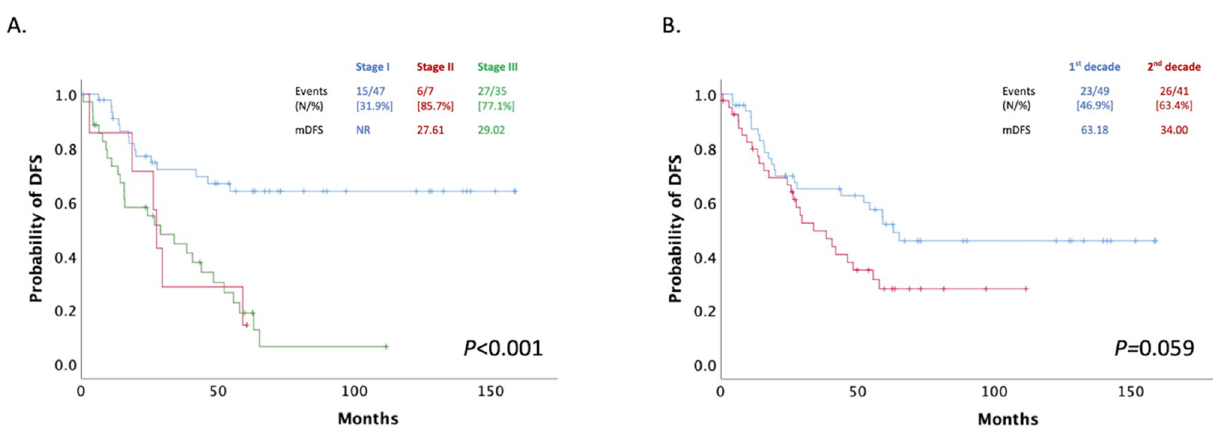
Figure 2. ( A ) Patients mDFS stratified by stage; ( B ) Patients mDFS after adjuvant treatment stratified by decade of treatment (1st decade: 1999–2009, 2nd decade: 2009–2019).